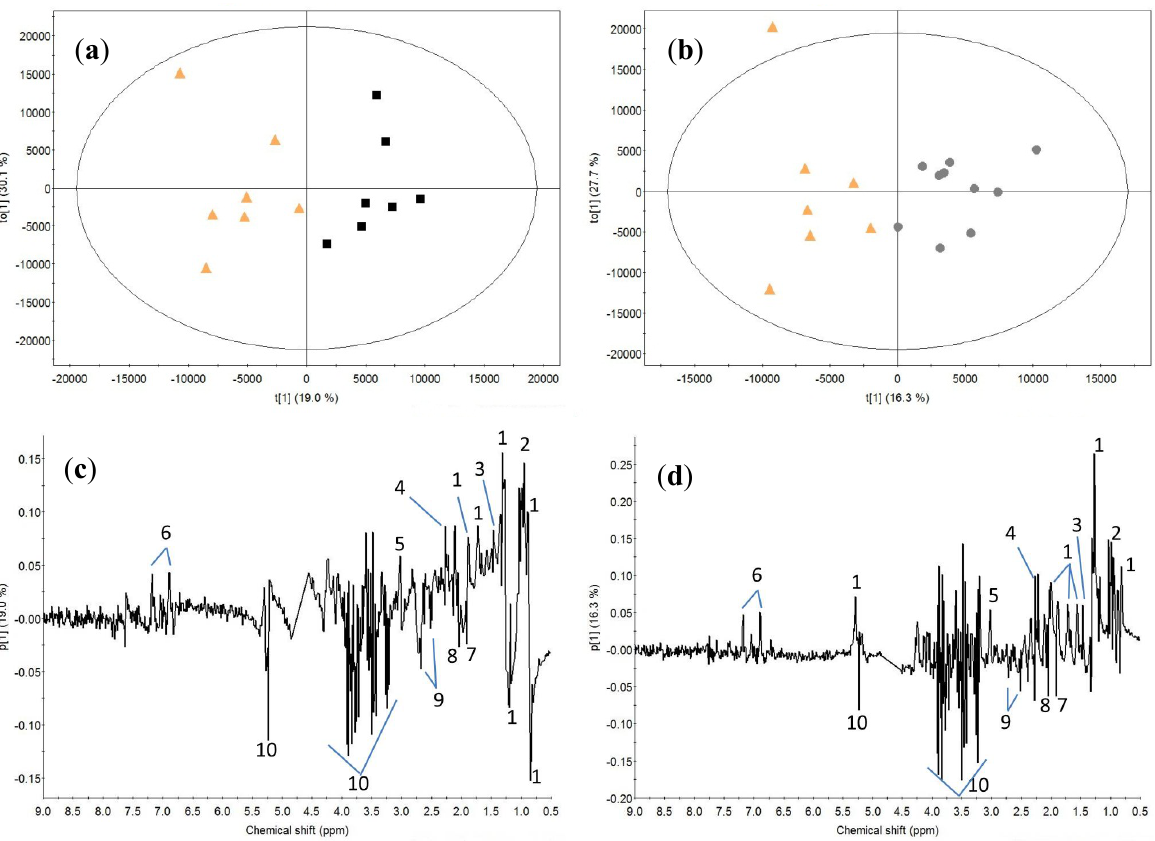
glucose. The ellipse represents the Hotelling